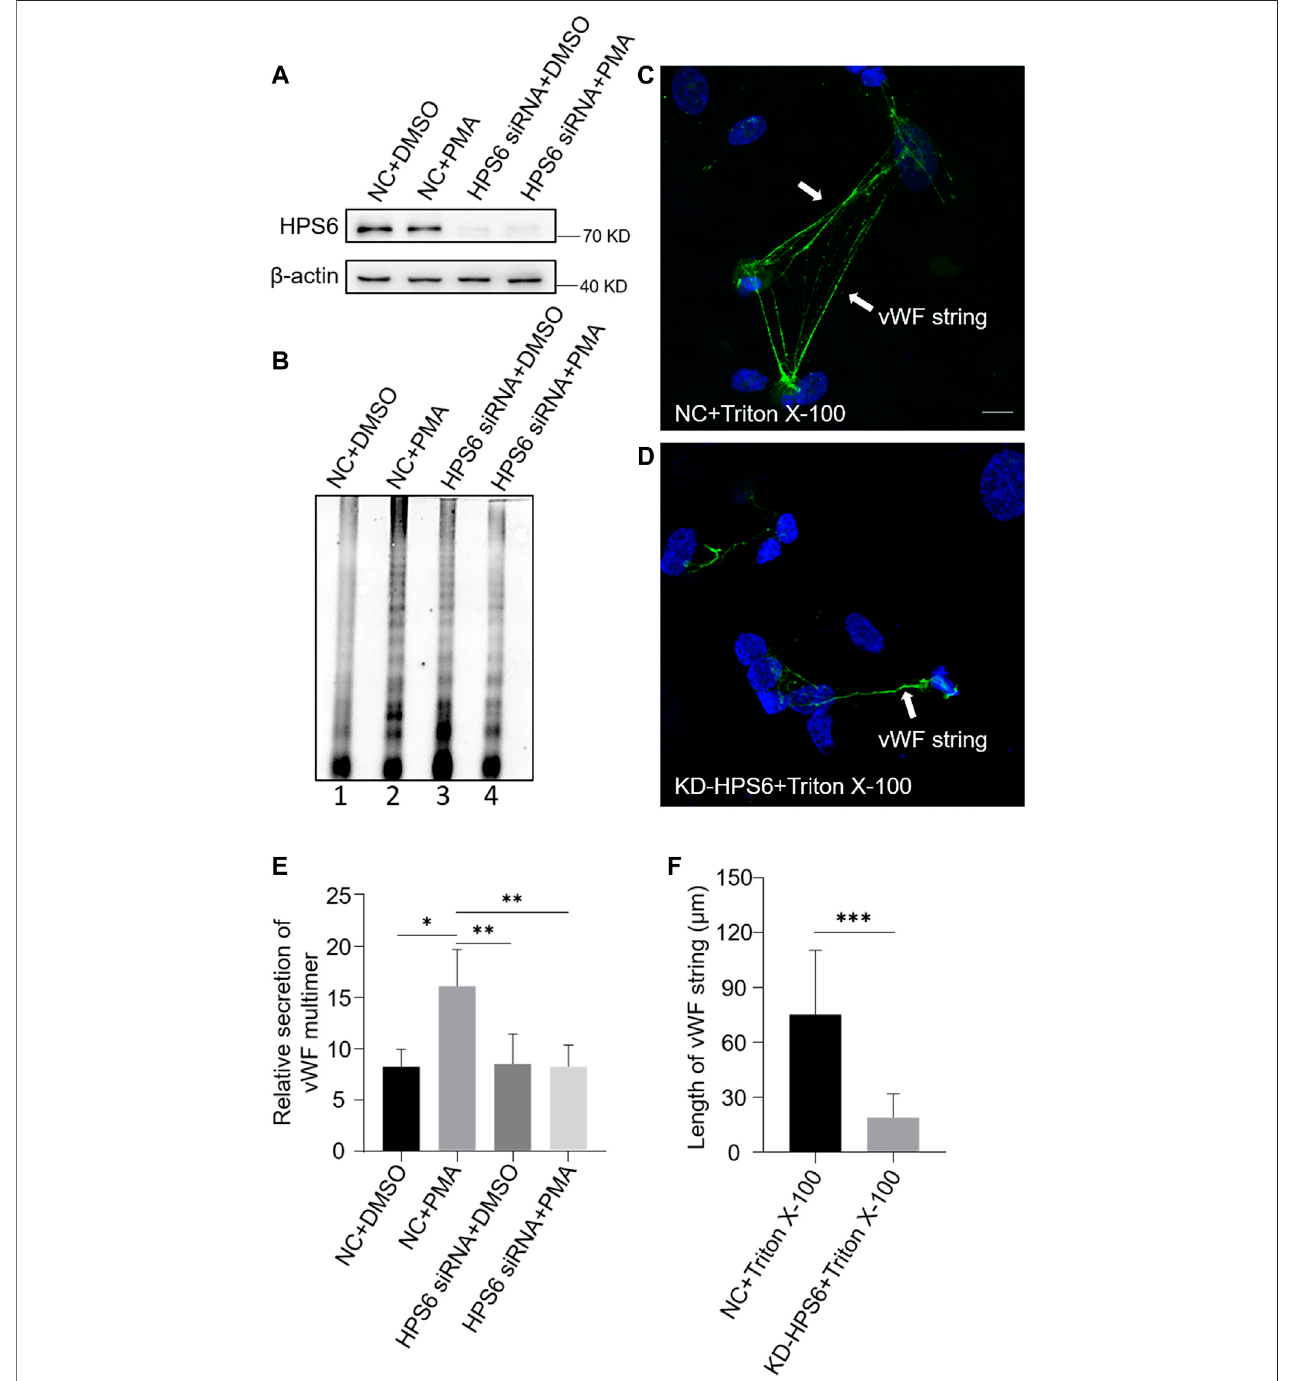
FIGURE 3 | von Willebrand factor (vWF) secretion and the ability to generate surface strings are compromised in KD-HPS6 human umbilical vein endothelial cells (HUVECs).Thenegativecontrol(NC)andHPS6siRNAweretransfectedintotwogroupsofHUVECs,respectively.At72 hlater,onegroupofNCandKD-HPS6cellswas exposedto80 nMPMAfor30 mintostimulateWPBsecretion,andtheothergroupswereexposedto0.1%DMSOinstead.( A )Westernblottinganalysisofthedetection of HPS6 knockdown in cell lysate collection. ( B , E ) Western blotting analysis of vWF multimer secretion in supernatant. The multimer gels were analyzed using the NIH ImageJ software. The quanti fi cation of supernatant vWF multimers was carried out based on the normalization of the β -actin protein level of the cells in each well. n = 5, * p < 0.05,** p < 0.01. ( C , D ) Moreover, 1% Triton X-100 was added into the culture medium of NC and KD-HPS6 HUVECs and cultured at 37 ° C for 1 h. Immuno fl uorescence images of two groups of HUVECs labeled against vWF (green) and nucleus (DAPI, blue) were shown. Scale bar, 10 μ m. ( F ) The length of vWF stringsateach groupofHUVECswasmeasuredbytheNIHImageJsoftware( n =30pergroup,*** p < 0.001).Datawereexpressedasmean±SEM.Threeindependent experiments were performed.